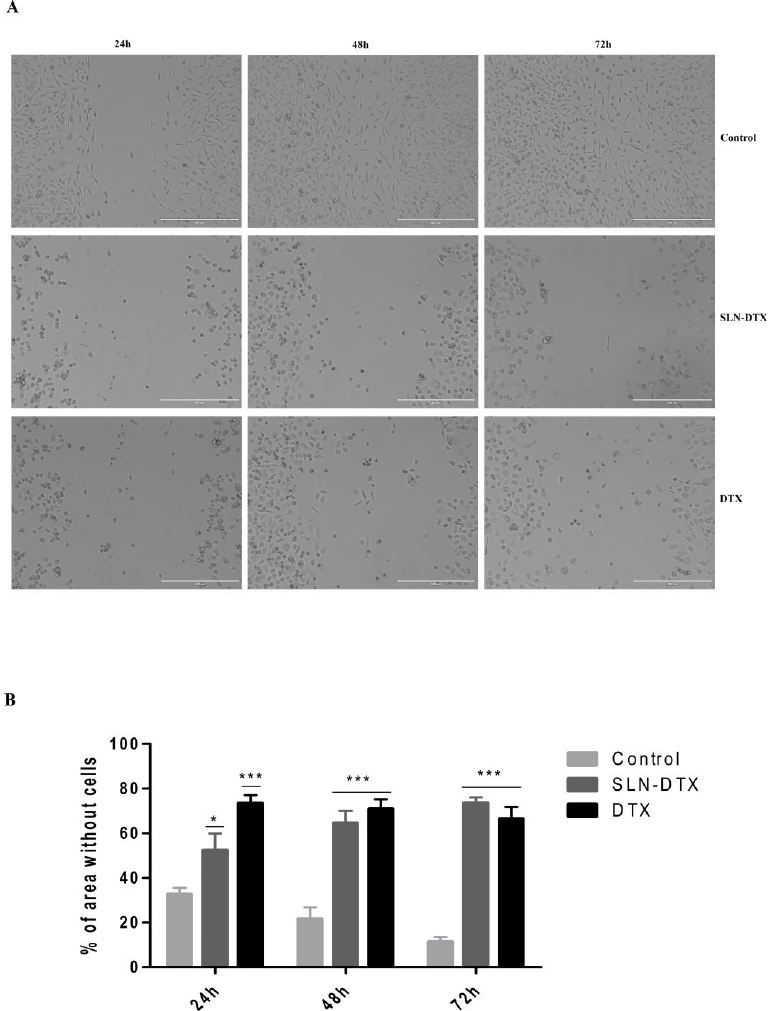
Figure 9. Analysis of wound healing of MDA-MB-231. ( A ) Light microscopy with control and the treatments with SLN-DTX and DTX, after 24 h, 48 h, and 72 h. Scale bar 400 µ m. ( B ) Histogram with an area without cells for each one of the treatments with the different times. Area results in triplicate of each of the treatments. * p < 0.05 and *** p < 0.001 compared to untreated control. The wound healing assay was used to evaluate the proliferation and cell mobility capacity of the MDA-MB-231 cells using the comparison between the migration of cells with the different treatments (SLN-DTX and DTX) and with the control. Cells treated with SLN-DTX have the ability to inhibit proliferation and mobility in a similar way to those observed in treatment with DTX. Both proliferation and mobility are important factors for growth and enable cells to migrate to distant organs, so this inhibition can prevent metastatic tumor formation [33 – 36]. 2.7. Cell Cycle Analyses